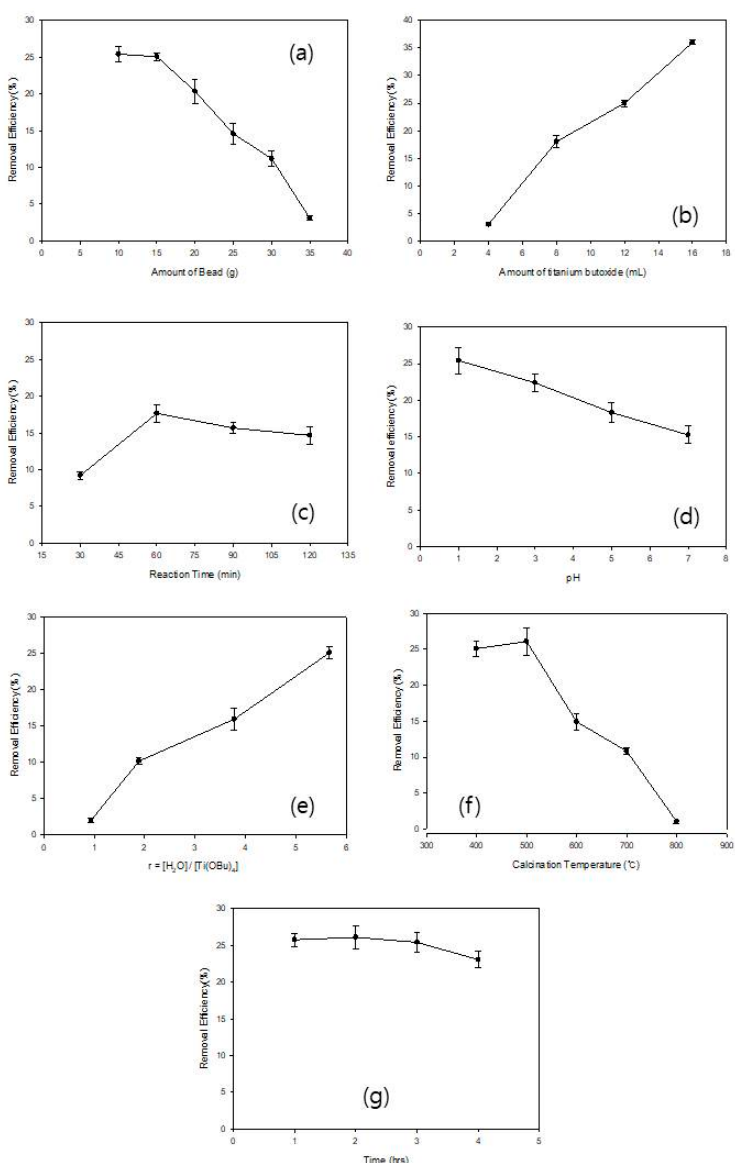
Figure 2. E ff ects of ( a ) amount of support, ( b ) amount of precursor, ( c ) aging time, ( d ) pH, ( e ) amount of water, ( f ) calcination temperature, and ( g ) calcination time in preparation of immobilized photocatalyst on the removal e ffi ciency of isopropyl alcohol (tested under synthetic wastewater initial concentration of 10 mg/L).